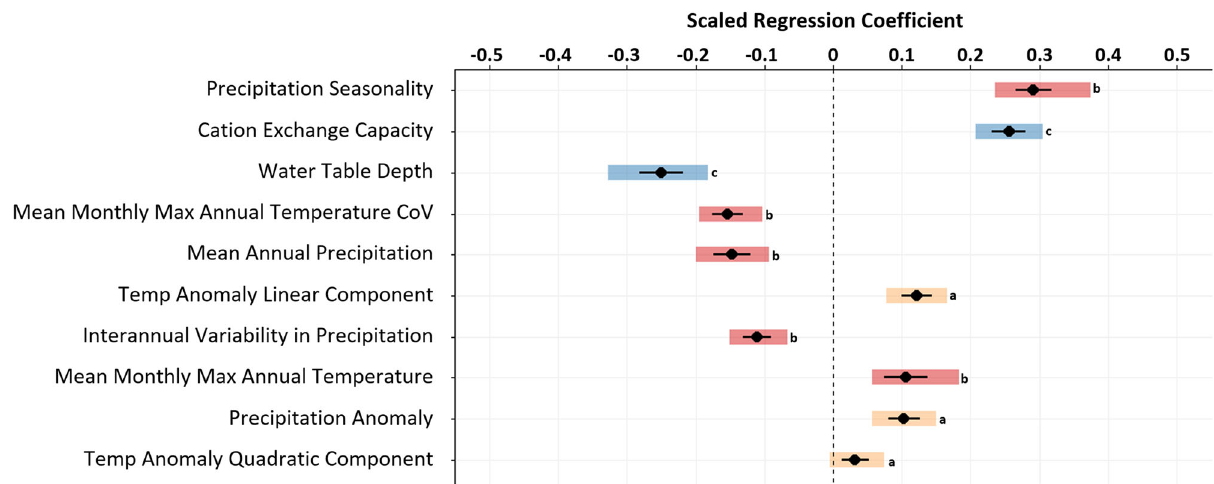
Fig. 2 Scaled and centred regression coef fi cients of fi nal model variables. Scaled and centred regression coef fi cients for all variables found in the fi nal model. Variables have been ranked by absolute magnitude of regression coef fi cient. Wings are standard errors and bars represent the 95% con fi dence intervals estimated via a bootstrapping analysis. Bars are coloured and numbered according to variable group: a yellow indicating ENSO-associated climate anomalies variables, b red denotes background climate variables and c blue represents soil